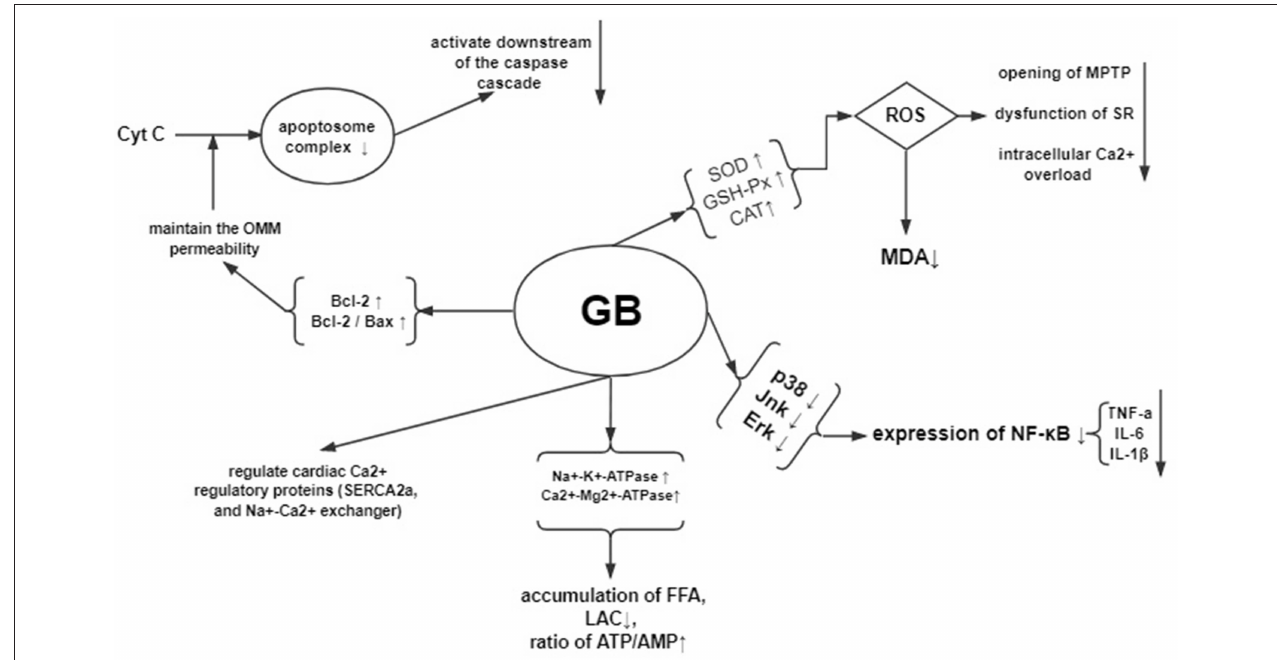
FIGURE 9 | Mechanisms of GB exerted cardioprotective effects in myocardial ischemia/reperfusion